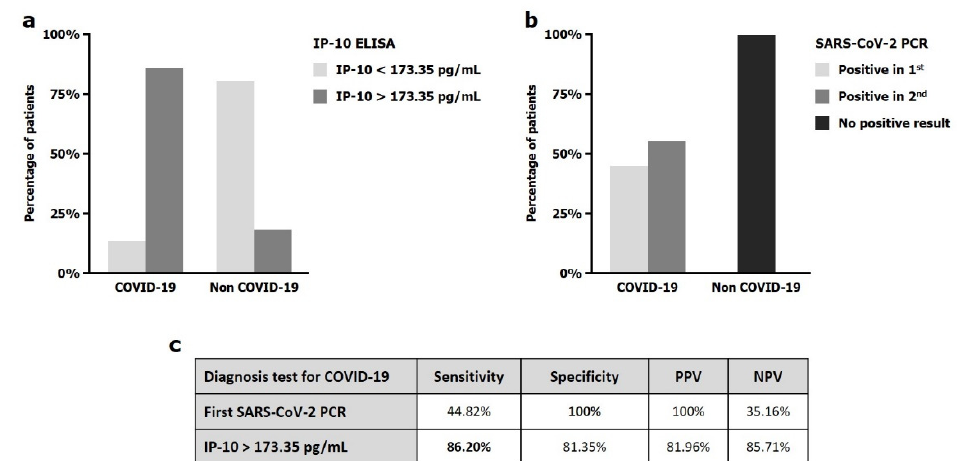
Figure 3. Histograms and table showing sensitivity and specificity diagnosis of IP-10 cut-off point